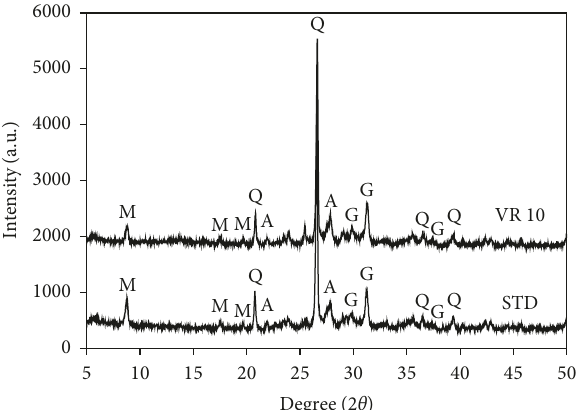
Figure 4: Mineralogical composition of FBCs at 850 ° C without GRPd (STD) and with 10% vol. addition of GRPd (VR 10). Q: quartz, C: calcite, M: muscovite, A: albite, and G: gehlenite.